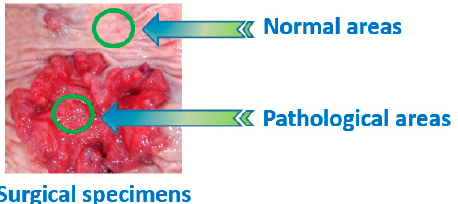
Figure 1. Surgical resection showing both normal and pathological areas of the colorectal mucosa.